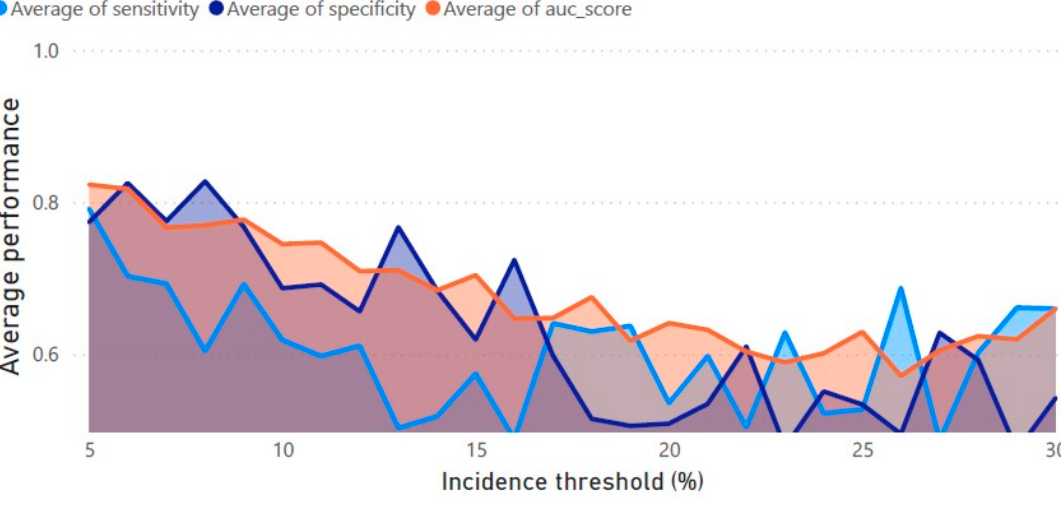
Figure 7. Area chart presenting the average performance (orange), sensitivity (light blue), and specificity (dark blue) of all tested classification algorithms for each tested stress incidence threshold.